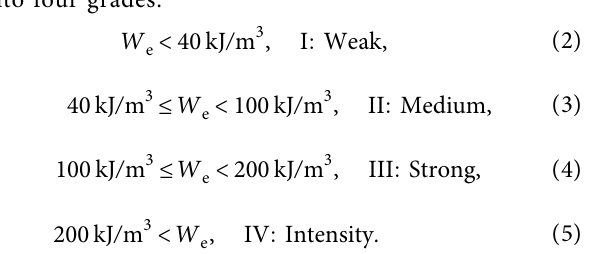
Figure 11: Elastic time-delay strain rebound monitoring